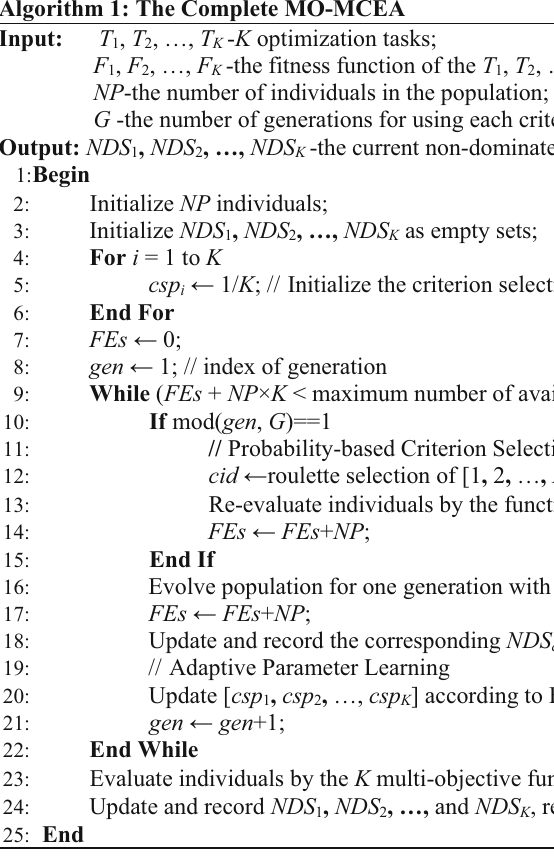
Algorithm 1: The Complete